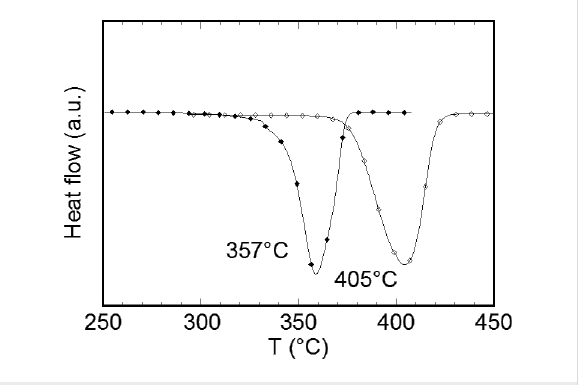
Figure 16: Thermodesorption of commercial MgH 2 (black diamonds) and commercial MgH 2 ground 4 h with 10% of C t , z carbon (open diamonds)